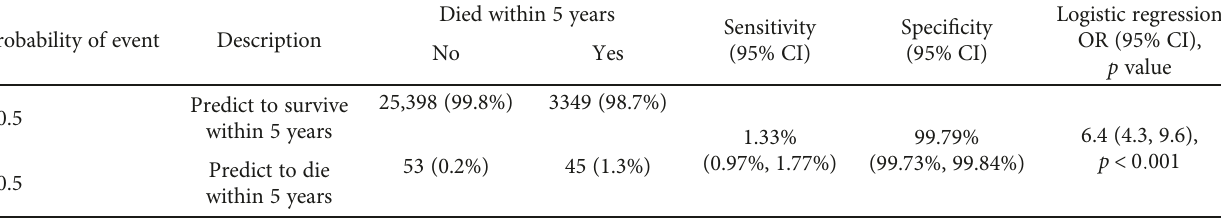
Table 5: Sensitivity and speci fi city analysis and logistic regression of probability of event of ≥ 0.5 in predicting mortality within fi ve years. Probability of